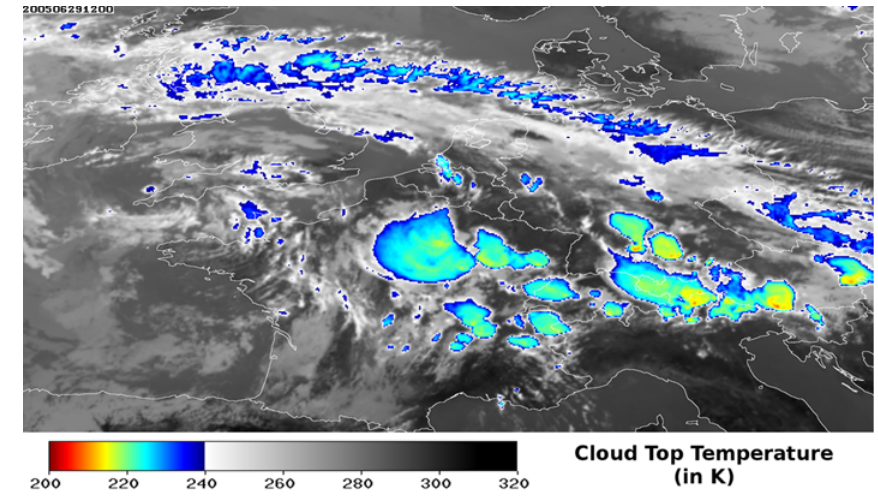
Figure 6. SEVIRI images of the cloud top temperature of the IR channel (29 June 2005 at 12:00UTC).